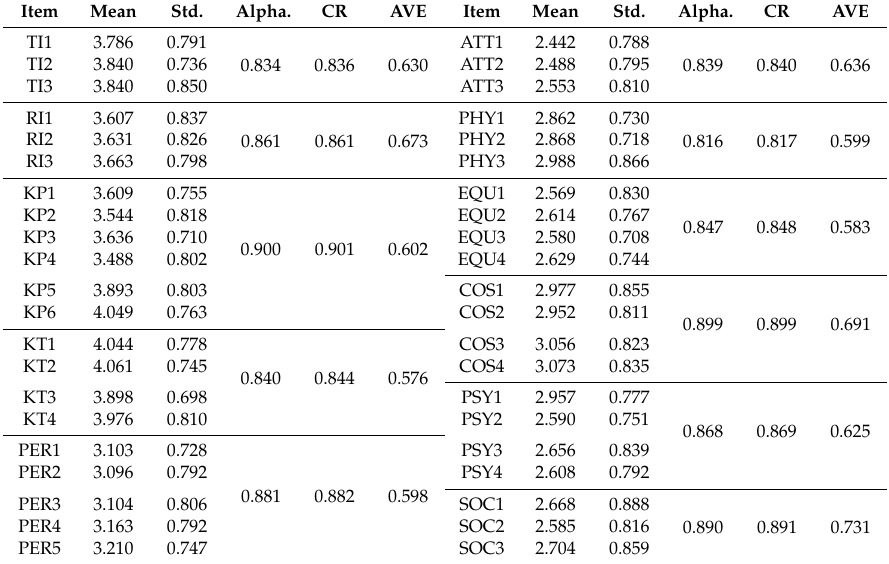
Table 4. Data quality.